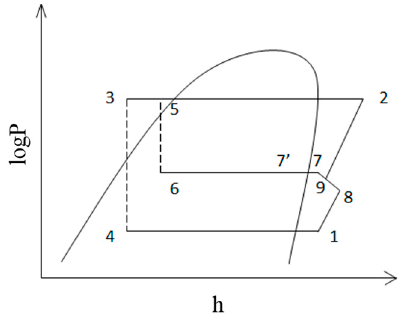
Figure 6. LogP ‐ h diagram of EVI system.